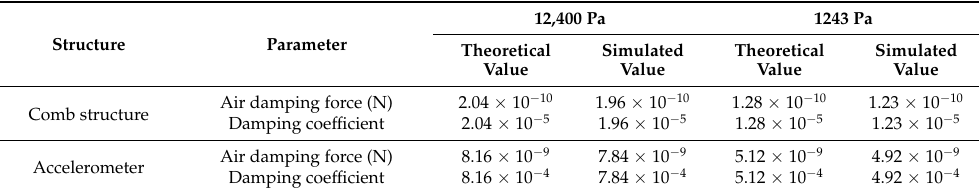
12,400 Pa 1243 Pa Theoretical Simulated Theoretical Simulated Value Value Value Value